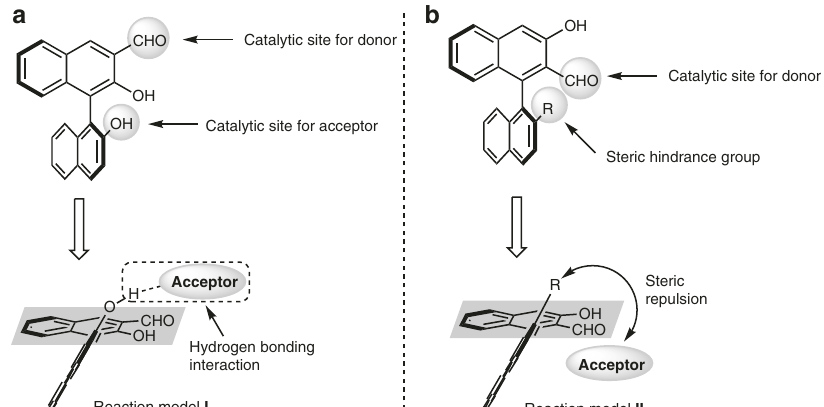
Fig. 1 Different reaction models induced by chiral BINOL aldehyde catalysts. a Reaction model I induced by 3-formyl BINOL aldehyde I . b Reaction model II induced by 2-formyl BINOL aldehyde II